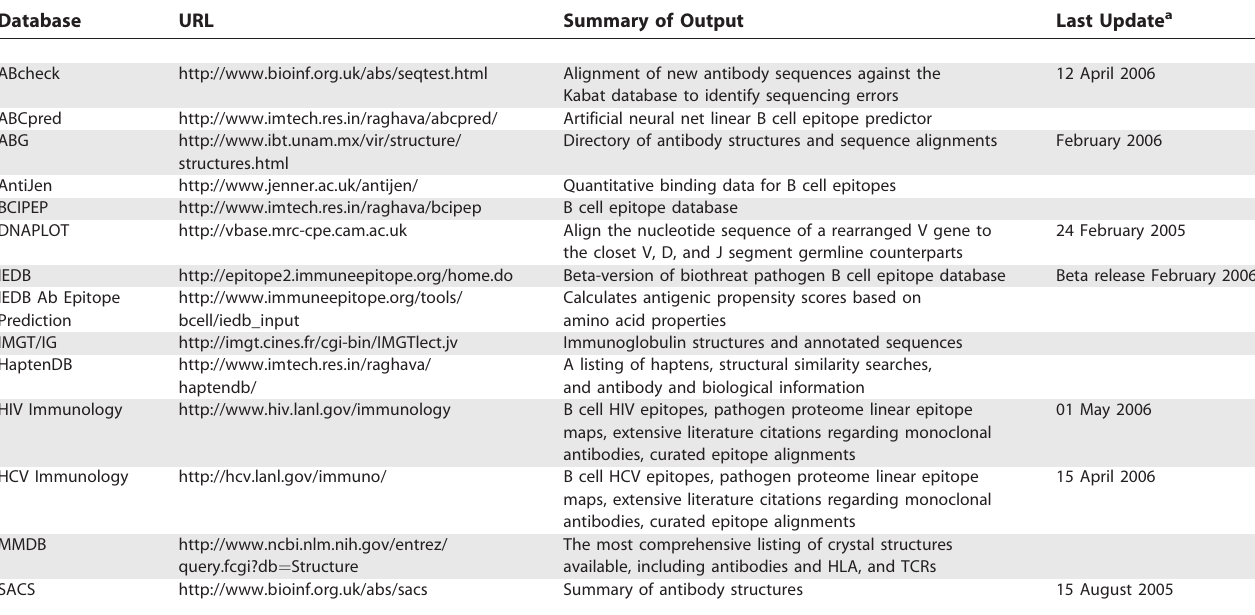
Table 3. B Cell/Antibody-Related Databases and Analysis Tools